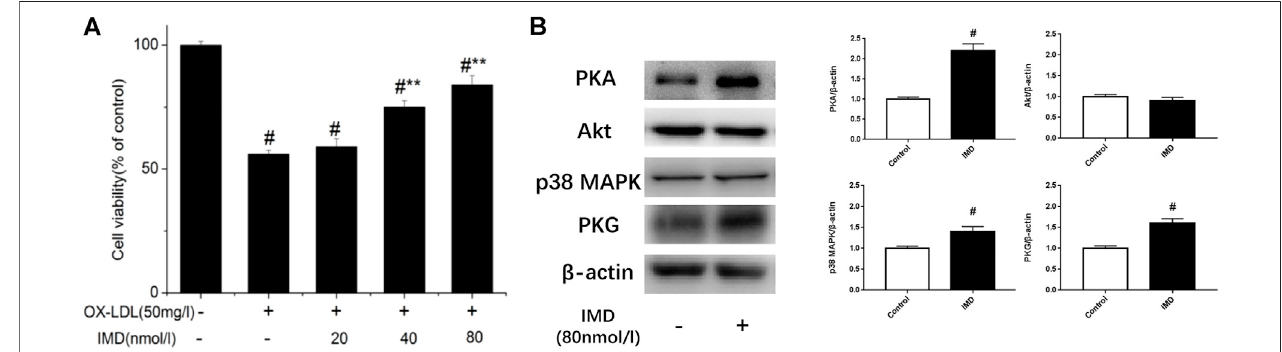
FIGURE1| Dose-dependentprotectiveeffectofIMDonox-LDL – inducedmacrophagesanditssignalingpathway. # Comparedwiththecontrolgroup( p < 0.05);** compared to the ox-LDL alone group ( p < 0.05).